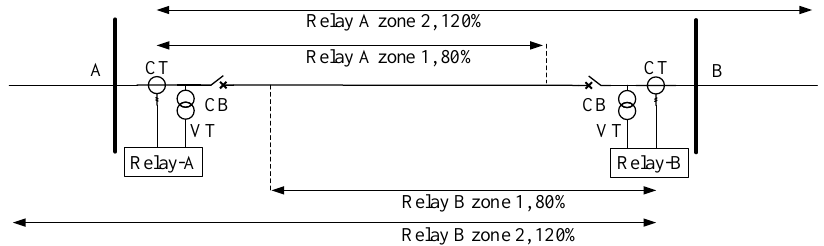
Figure 1. Simple transmission line model with distance